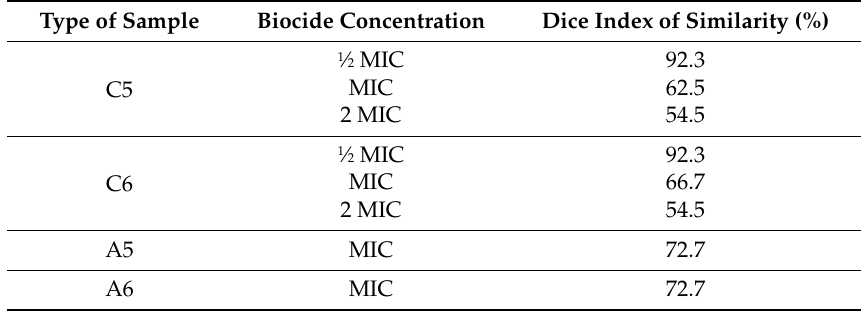
Figure 1. ( A ) Effect of neutral (A5 and A6) and cationic (C5 and C6) gemini surfactants on extracellular protein profiles of A. brasiliensis ATCC 16404 at MIC; changes in protein profiles after ( B ) C5 and ( C ) C6 treatment at 1 ⁄ 2 MIC, MIC, and 2 MIC in comparison with the sample without biocide (K). The sizes of the bubbles are related to pixel intensities in the protein profile patterns. Table 2. Similarity of protein profiles of A. brasiliensis ATCC 16404 after treatment with gemini surfactants.